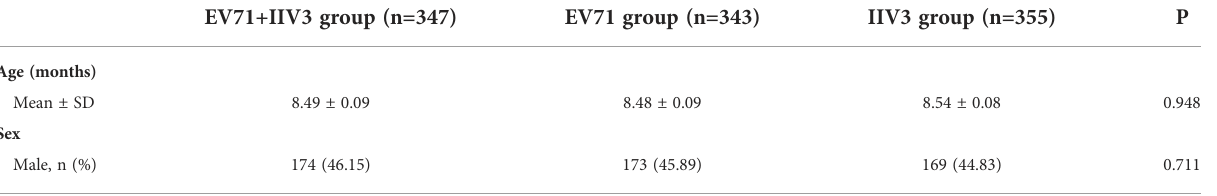
TABLE 1 Baseline characteristics in the per-protocol